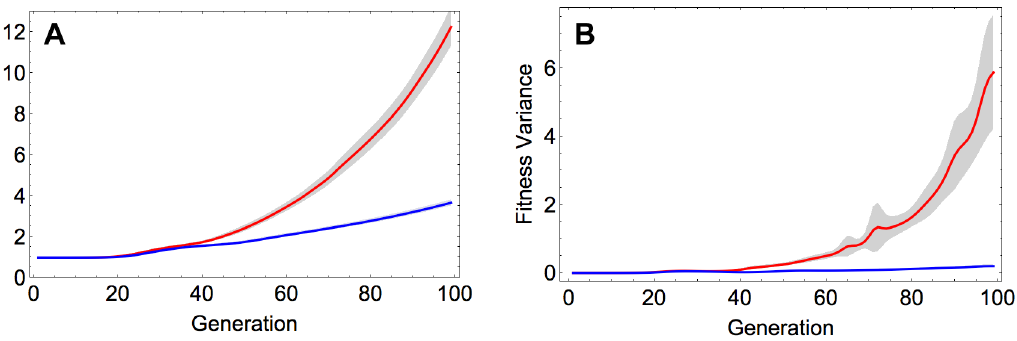
Figure 1. A) Population fitness and B) fitness variance in the recombining and non-recombining populations over time. Red and blue curves correspond to the mean value across 100 simulations in the recombining and non-recombining settings, respectively. Fitness and fitness variance values are normalized with the fitness of the reference sequence. The shaded regions show 95% confidence intervals. Parameters take values: N ~ 10 5 , r ~ 10 { 1 and u ~ 10 { 3 .